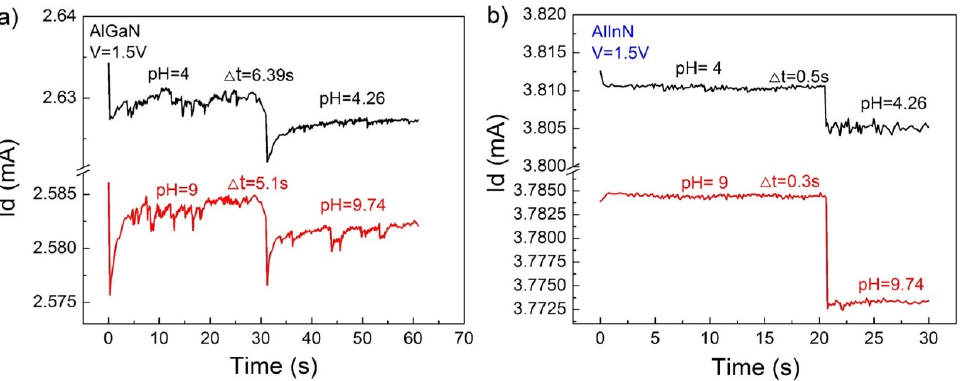
Figure 6. The transient response time of two structures’ devices when the solution pH value changes from 4–4.26 and from 9–9.74. ( a ) AlGaN/GaN heterostructure device; ( b ) AlInN/GaN heterostructure device.